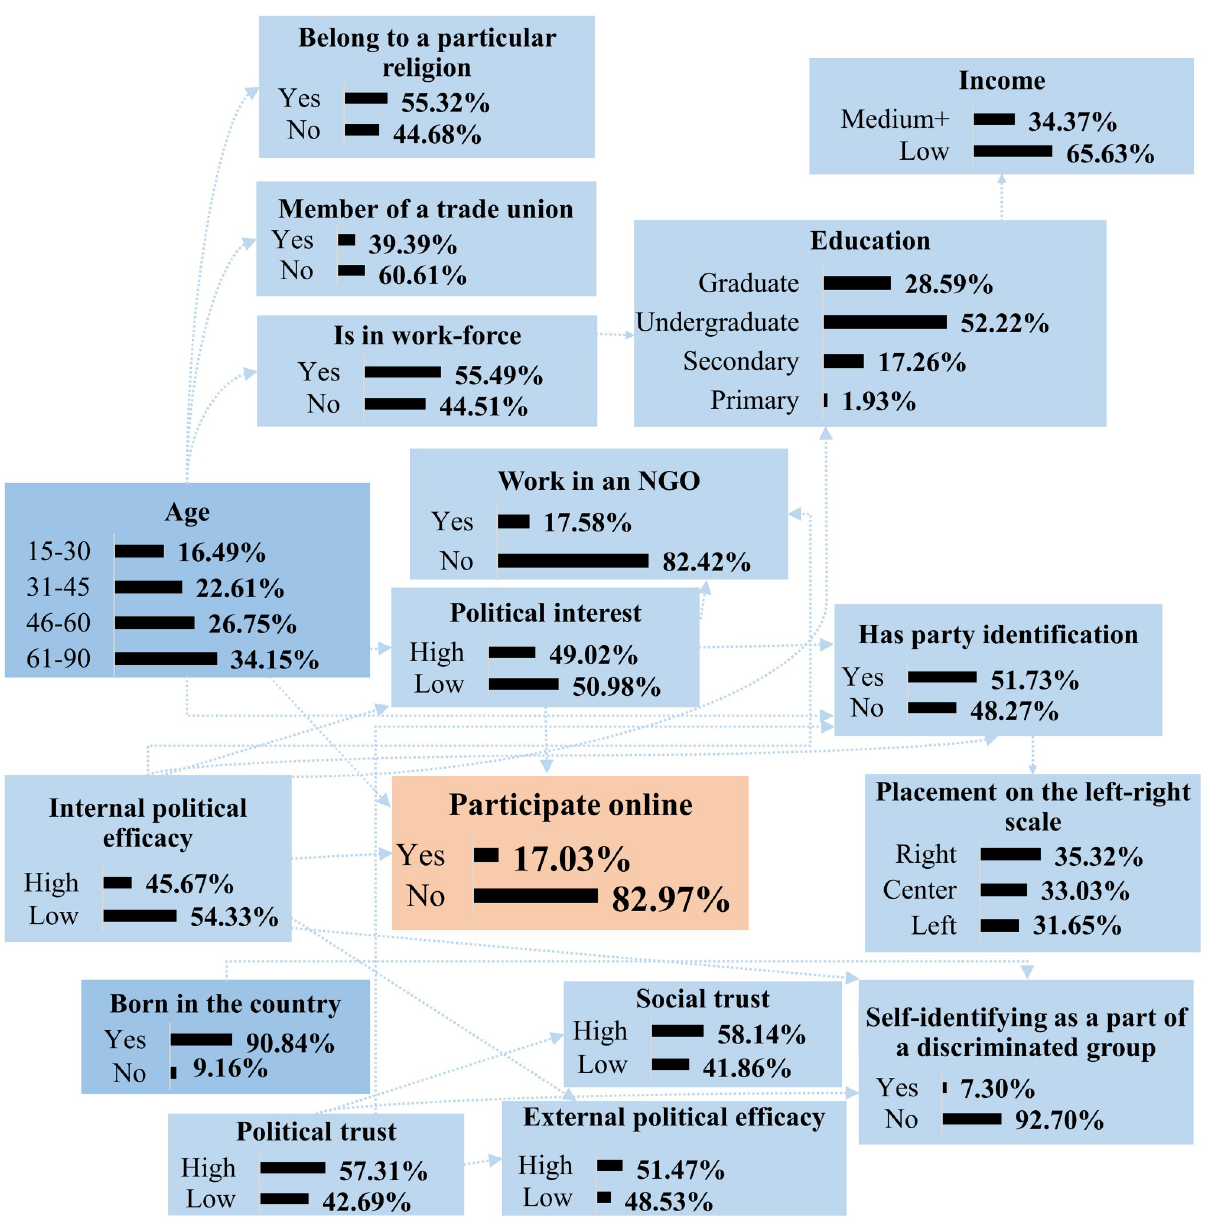
Fig 6. Probability distribution of all factors associated with participation in online activism. Source : ESS 2018 [35]. N = 27 379 individuals in 19 countries. Notes : Bayesian parameter estimation, conditional on the acquired structure of the network, was applied to analyse the data. Entities are the probabilities of events in